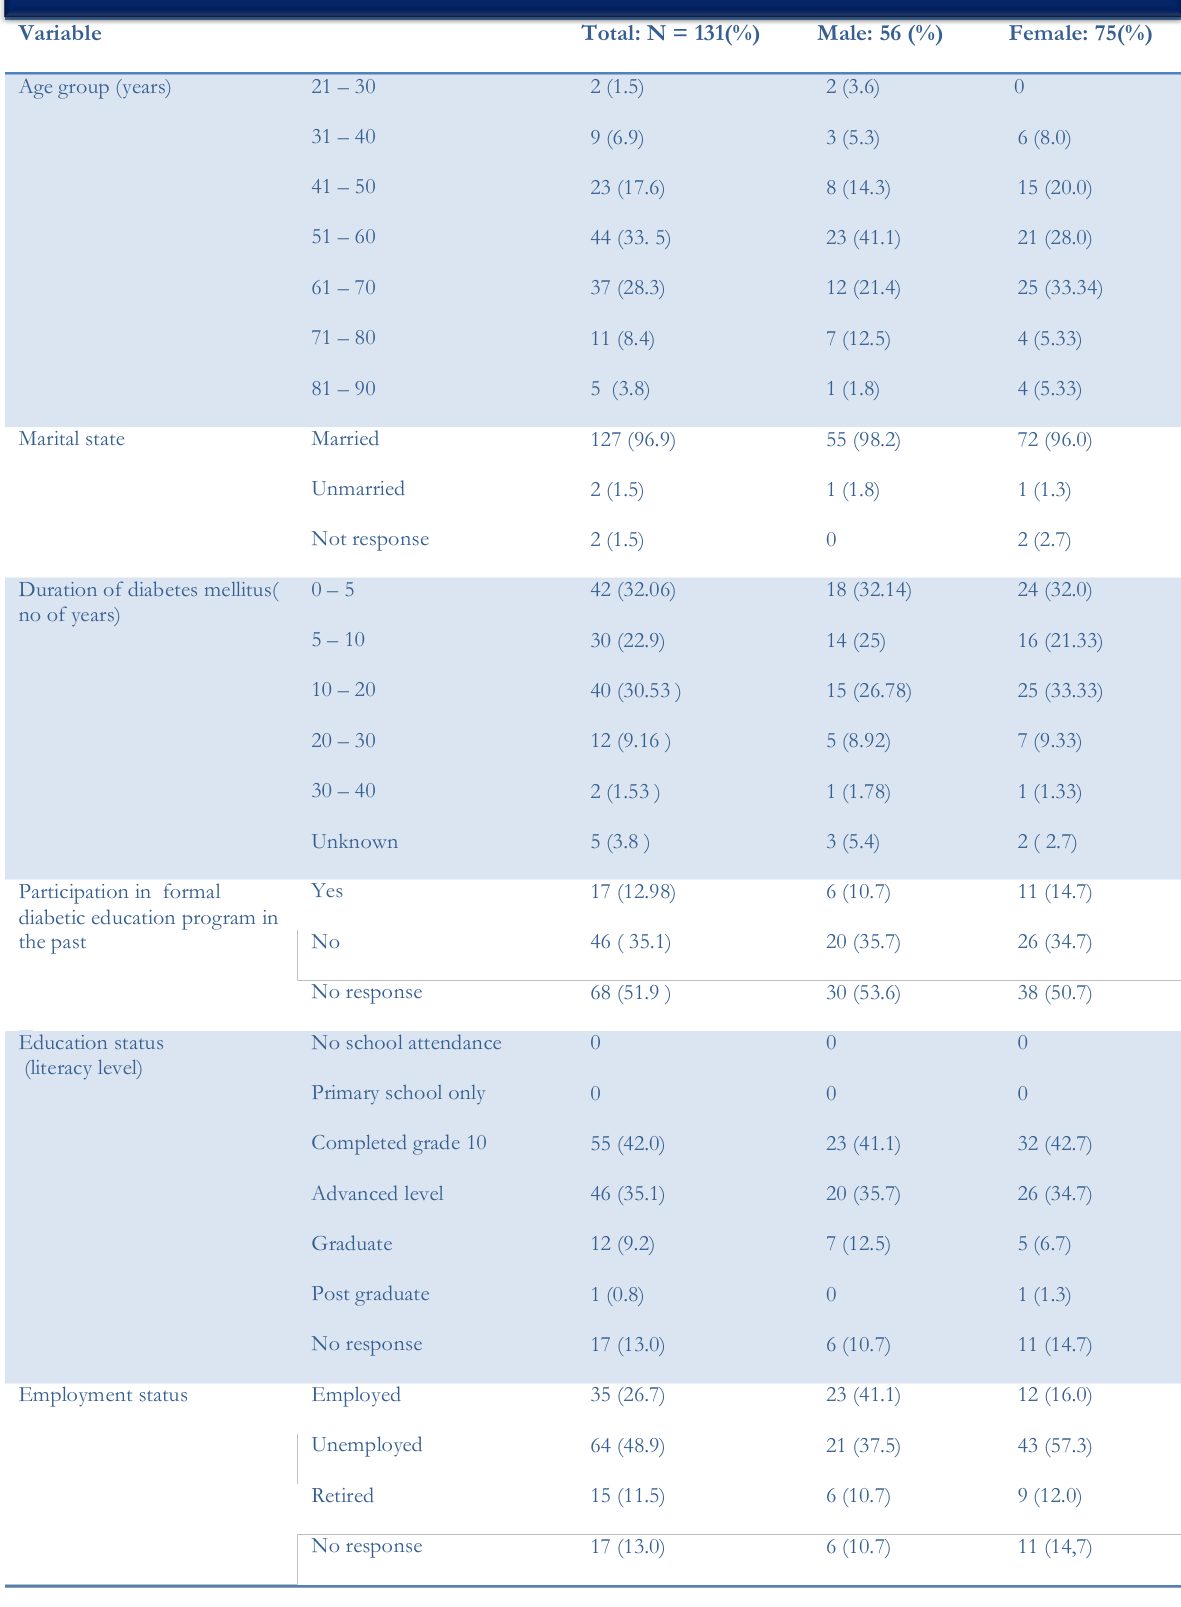
Table 1: Socio-demographic profile of study